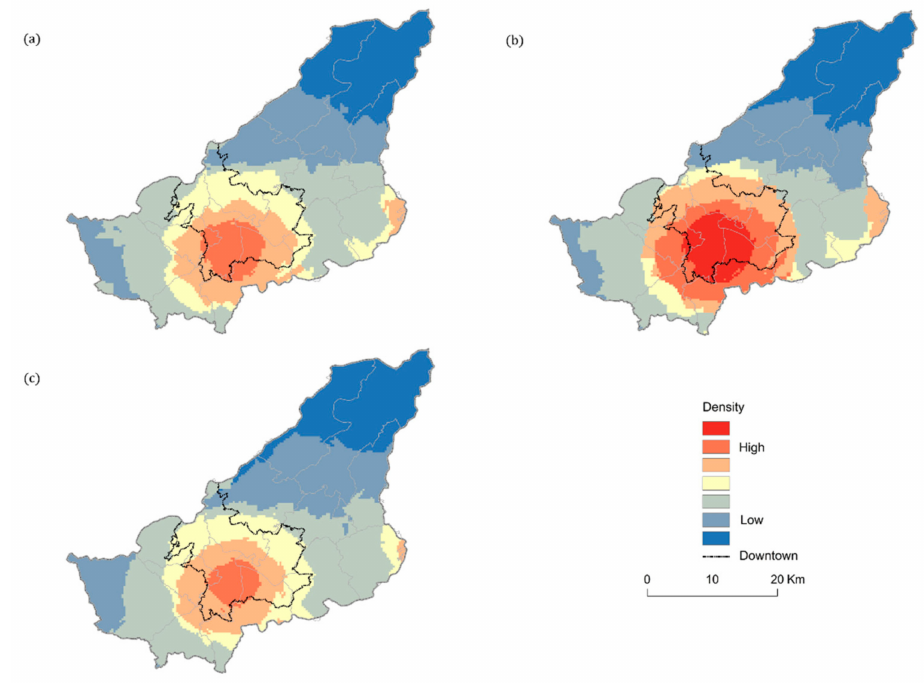
Figure 4. User density map of Tencent Location Big Data in Changshan County: ( a ) 30 August, ( b ) 13 September, ( c ) 27 September (the density value, which was standardized, does not represent the actual number of